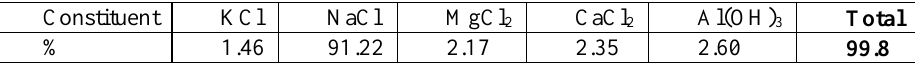
Table 2. Chemical analysis of electro-floated